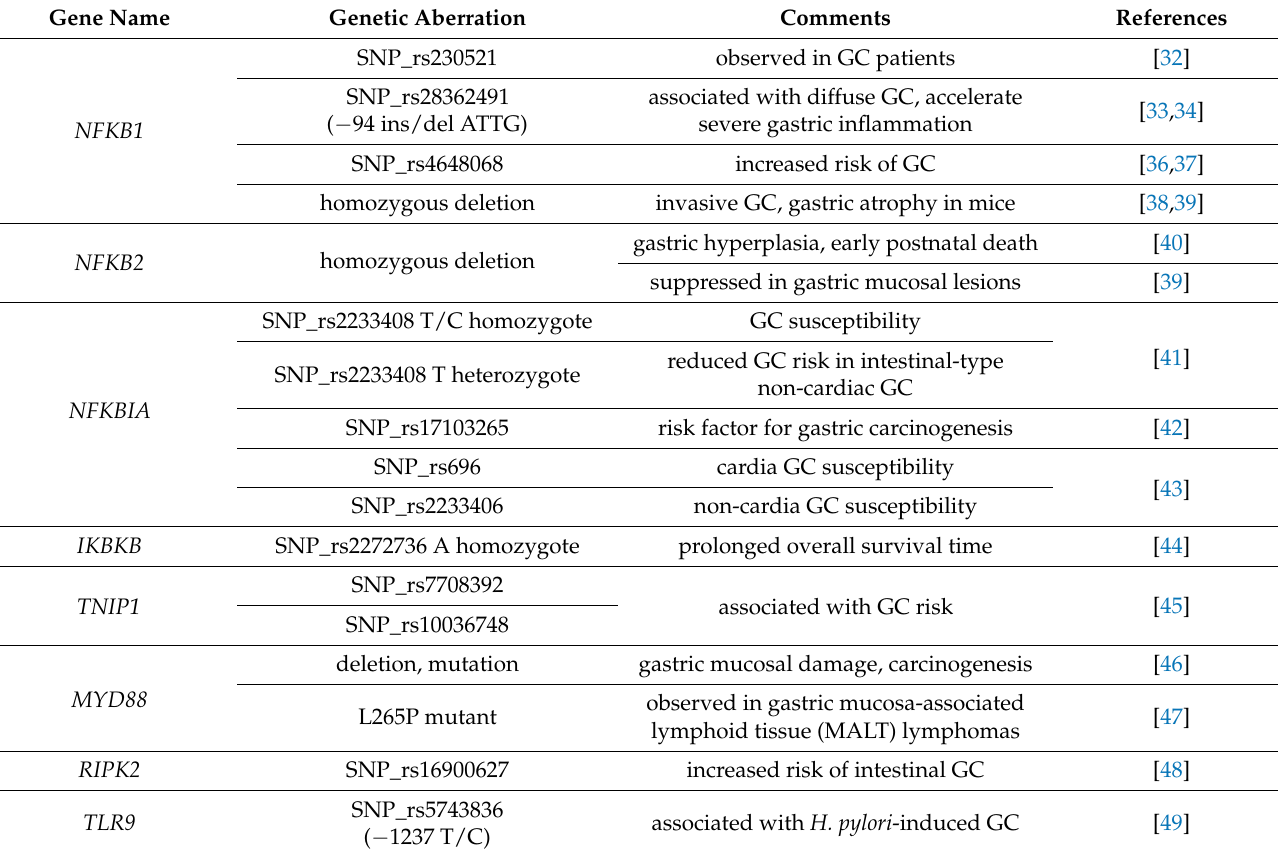
Table 1. Polymorphisms in NF- κ B genes and genes of NF- κ B signaling